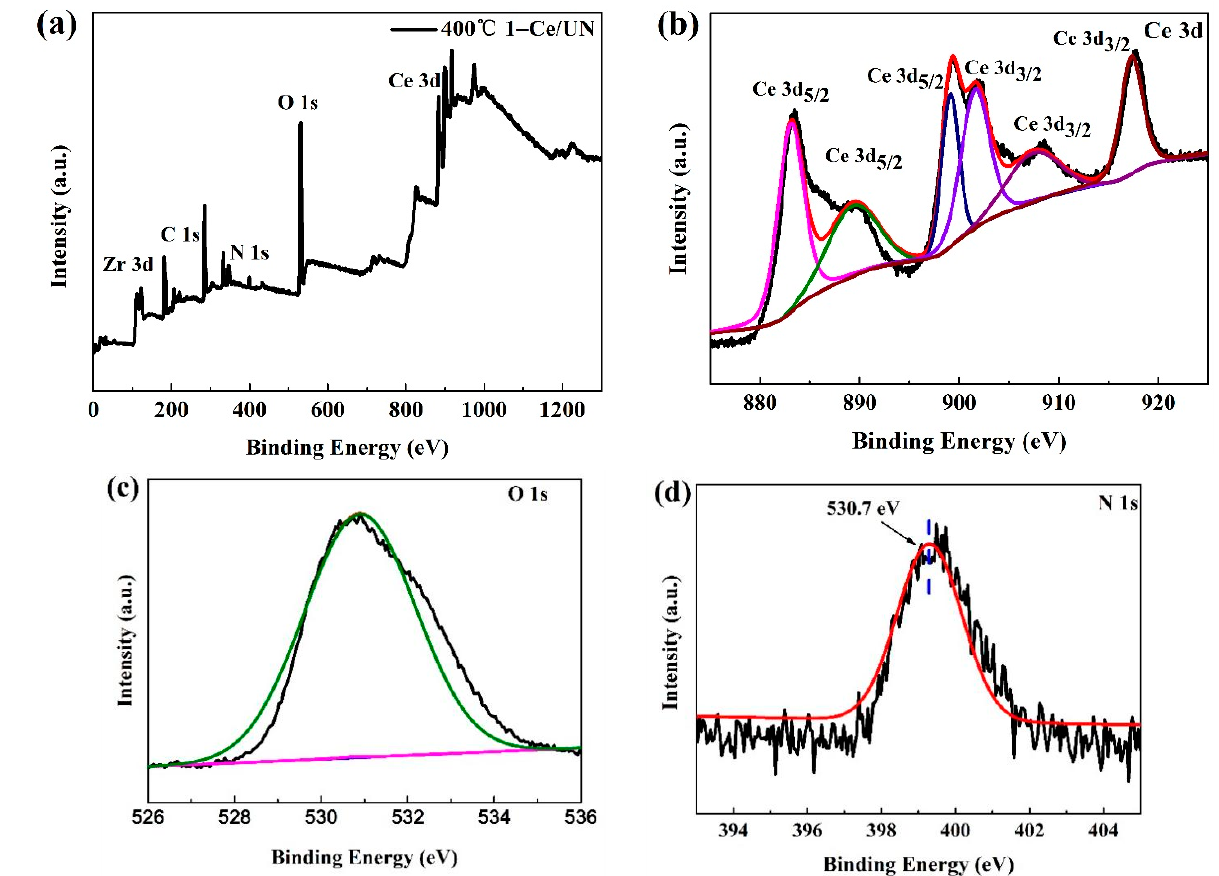
Figure 11. XPS spectra of 400 °C 1-Ce/UN catalyst: ( a ) Survey, ( b ) Ce3d, ( c ) O1s, ( d ) N1s.